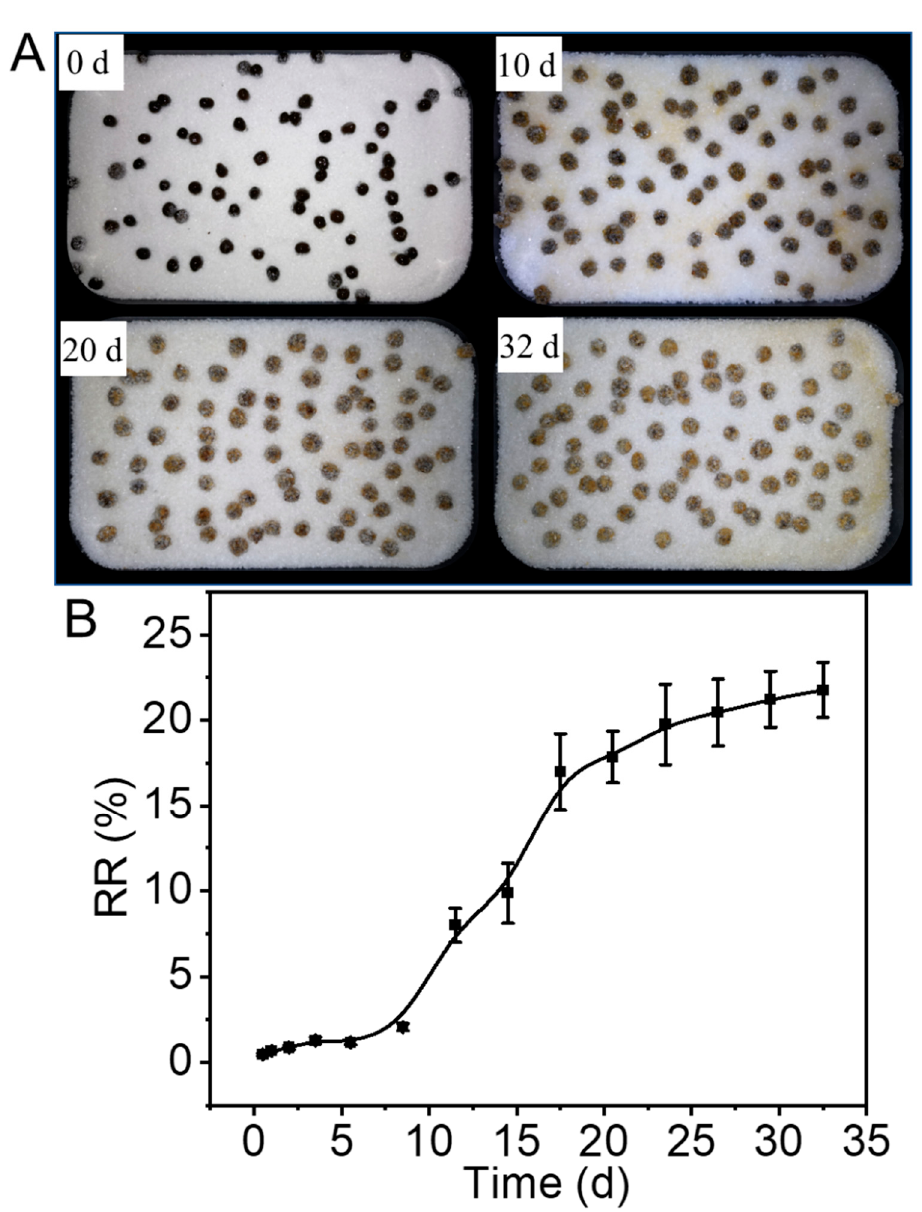
Figure 3. ( A ) Digital photographs of OACT@ASO on silica sand and ( B ) RR of FA from OACT@ASO in silica sand at 30 °C.